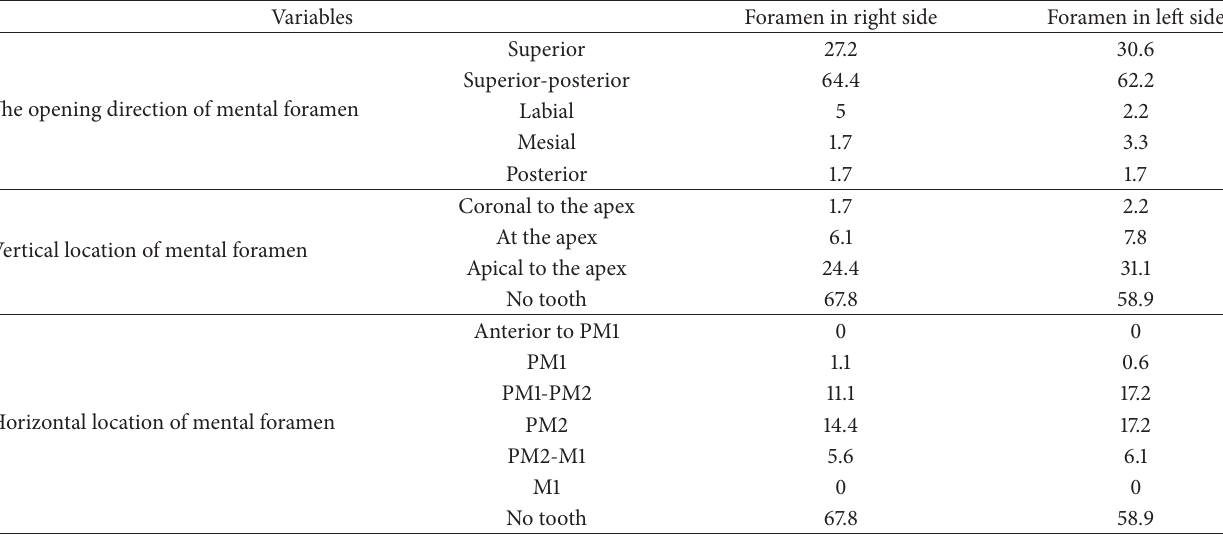
Table 1: The frequency (%) direction of opening, vertical, and horizontal locations of mental foramen. Variables